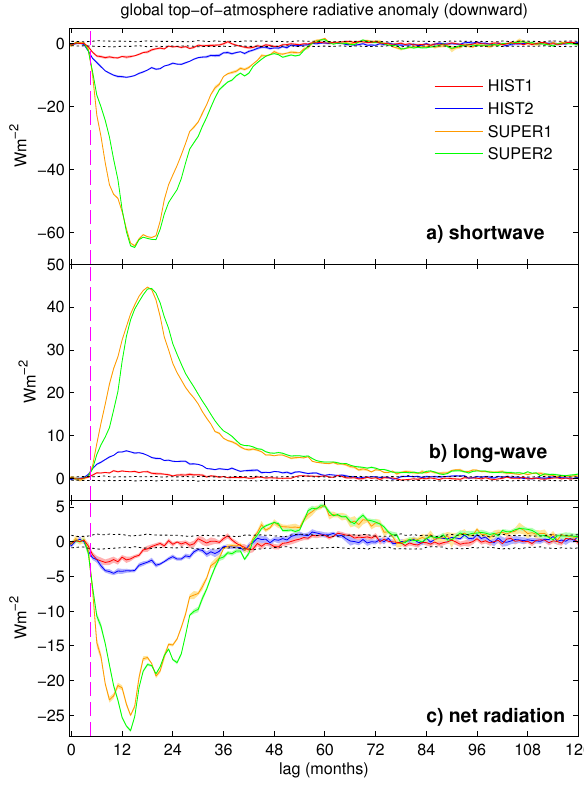
Figure 1. Simulated imposed forcing in the two historical and the two supervolcano ensembles as diagnosed through anomalies in the global-average top-of-atmosphere solar (shortwave, a ), thermal (long-wave, b ) and net (c) radiation. Lines and shading represent the mean and standard error of the mean respectively. Black dot- ted lines indicate the internal variability range ( n = 10; see meth- ods). The dashed vertical magenta line indicates the approximate start of the eruptions. Lag(0) corresponds to January of the eruption year. Positive anomalies correspond to increased downward flux. No smoothing was applied to the